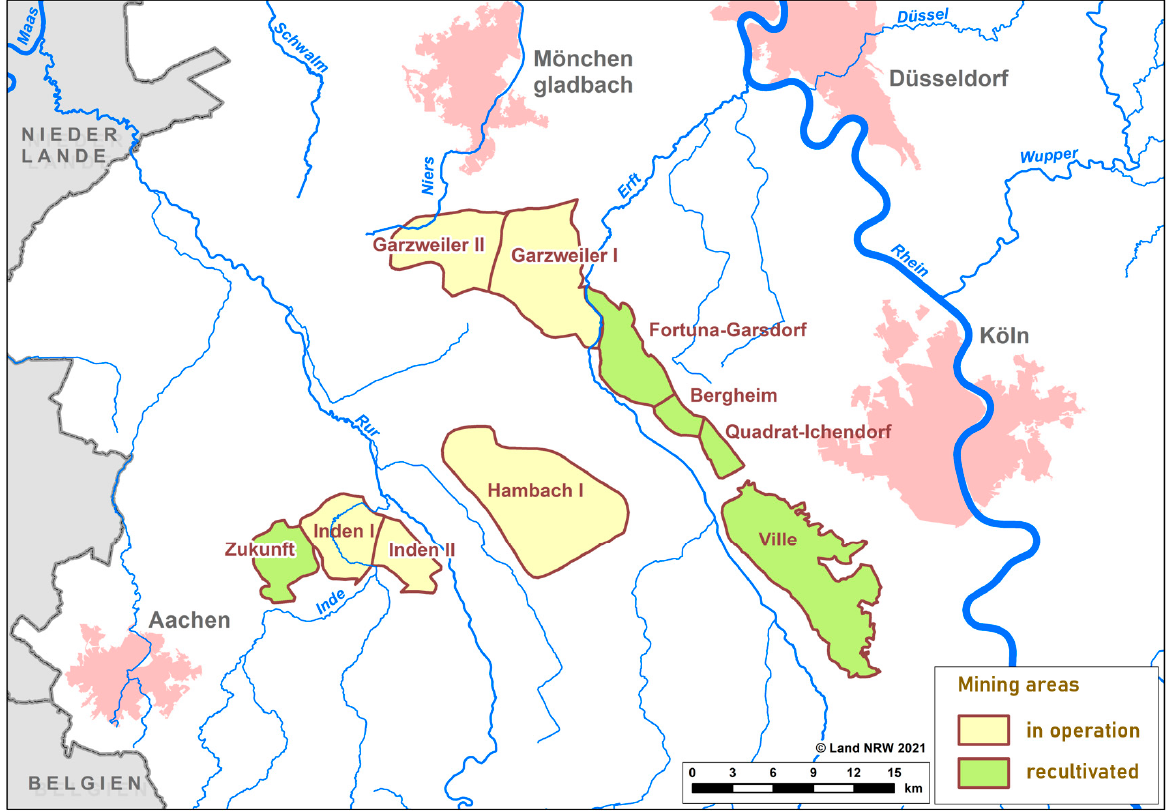
Figure 2. The Rhenish coal mines. Adapted with permission from [14].